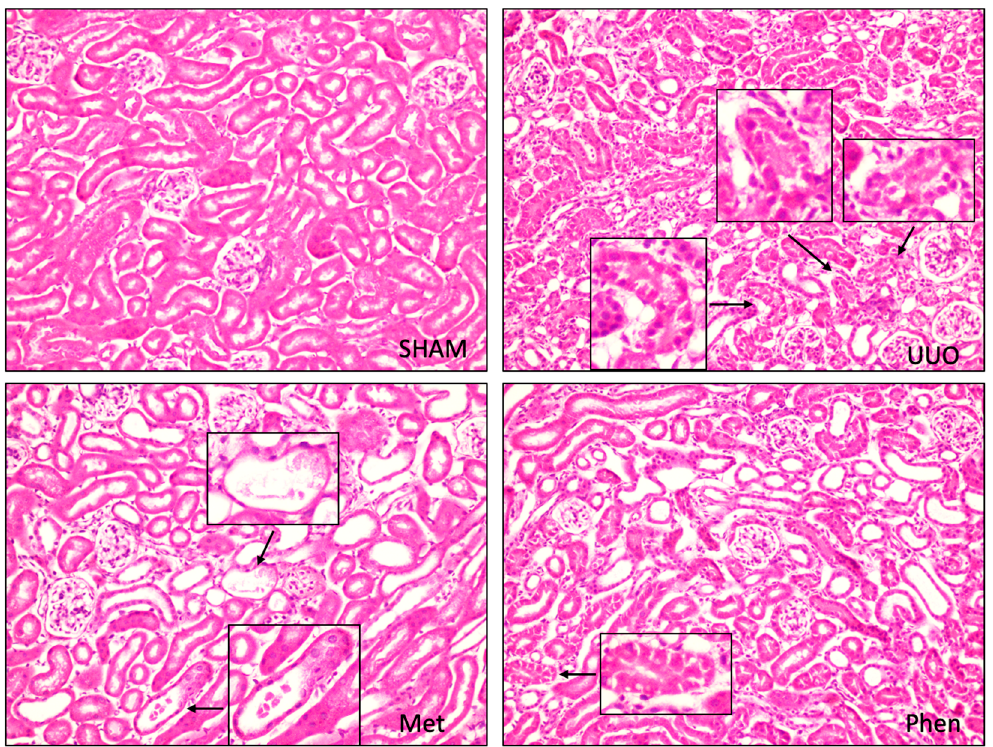
Figure 3. Representative images of renal morphology. Injured tubules are marked by arrows. 20 × magnification, n = 4 for each group.